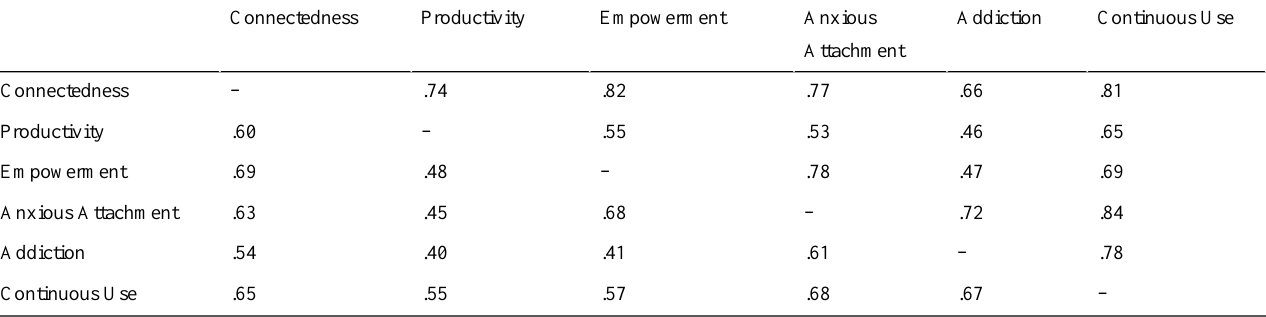
Table 3. Disattenuated correlations among 6 latent constructs from confirmatory factor analyses (upper-right triangle), with the raw summated scale score correlations (lower-left triangle).